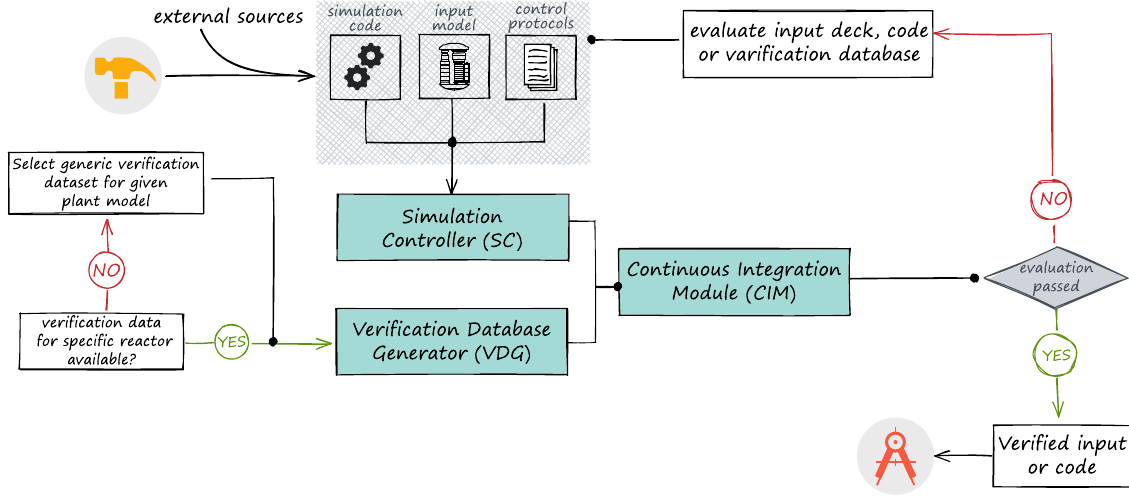
Fig. 5. Flow diagram for the Automatic Model Verifier